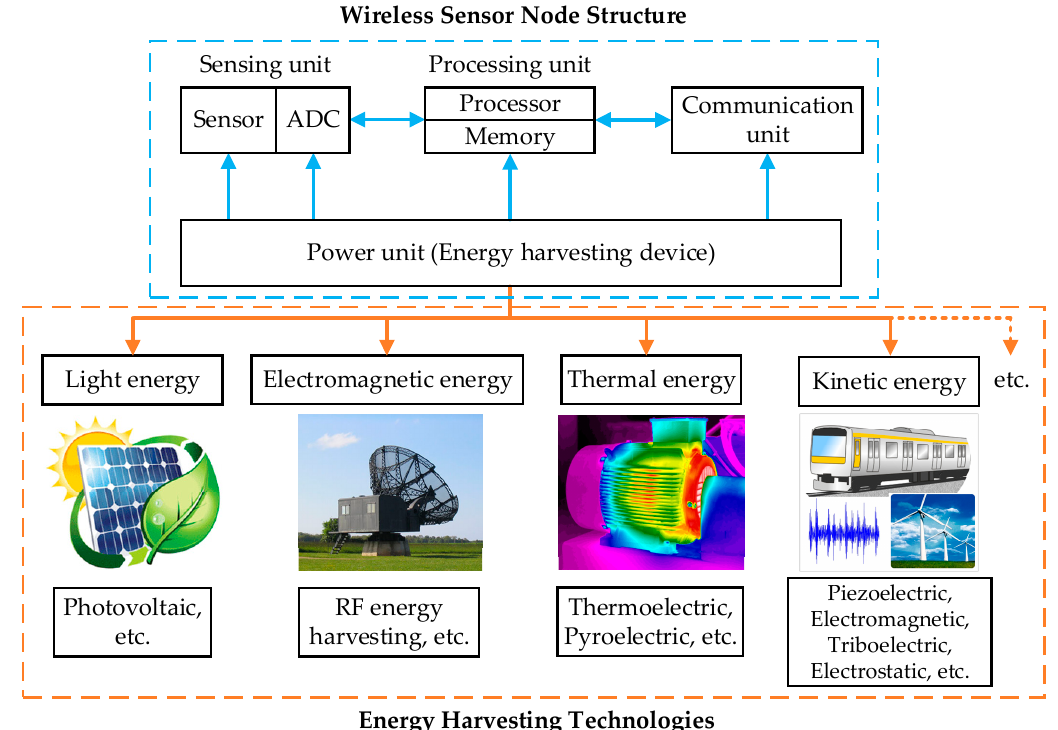
Figure 1 . Wireless sensor nodes powered with energy harvesting techniques. Figure 1. Wireless sensor nodes powered with energy harvesting